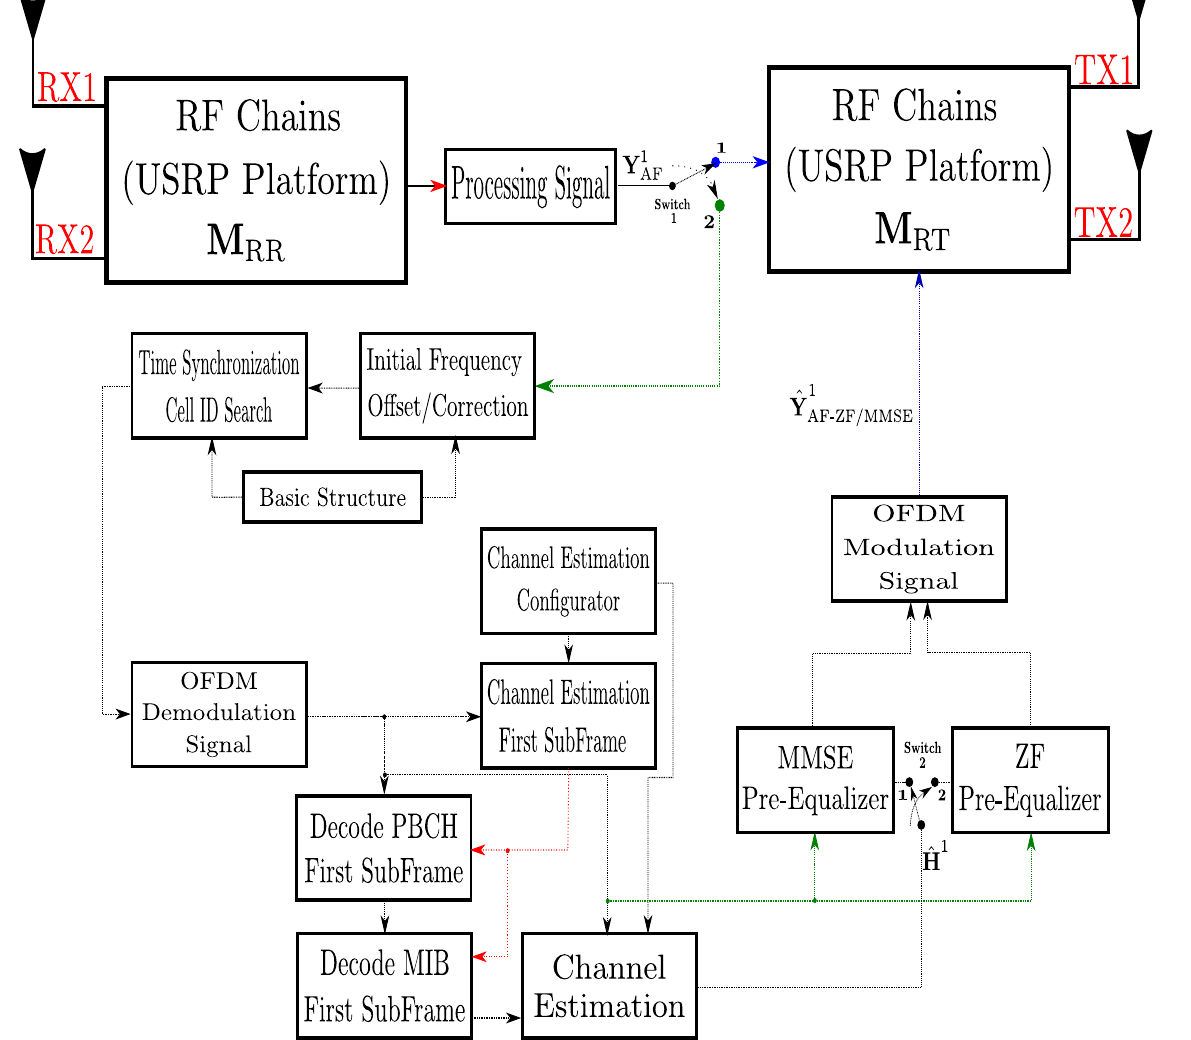
Figure 8. MIMO Amplify-&-Forward Relay Node Processing